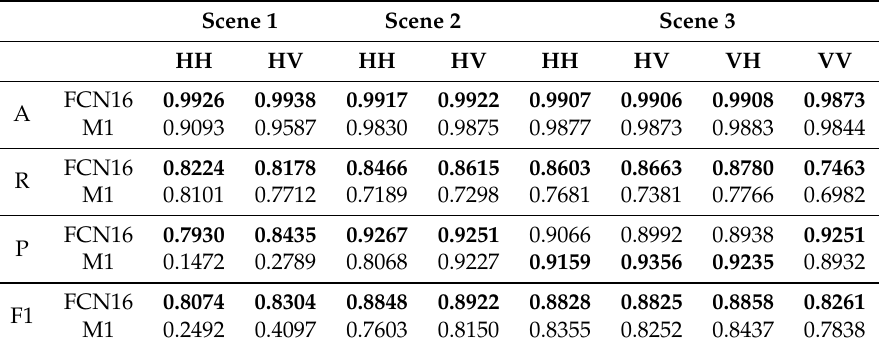
Figure 11. The comparison of four indices under different training set sizes: ( a ) accuracy; ( b ) recall; ( c ) precision; and ( d ) F1 score. In each figure, the horizontal axis represents different images and the vertical axis represents the corresponding index. Table 6. Index comparison between FCN16 with p equal to 0.1 and M1. A is accuracy, R is recall, P is precision, and F1 is F1 score, given in Equation (3). The better results are in